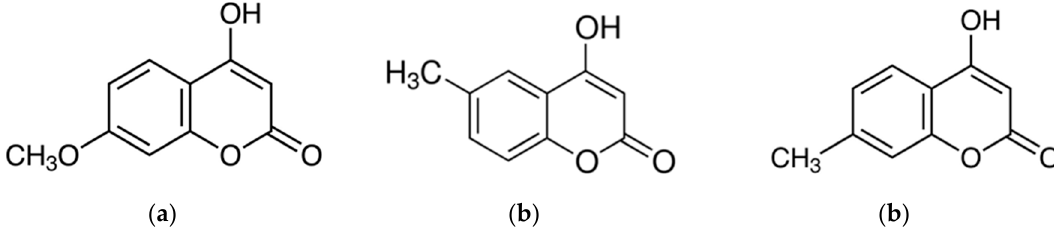
Figure 1. Structures of 4-hydroxycoumarins: 4-hydroxy-7-methoxycoumarin ( a ), 4-hydroxy-6-methylcoumarin ( b ), and 4-hydroxy-7-methylcoumarin ( c ).